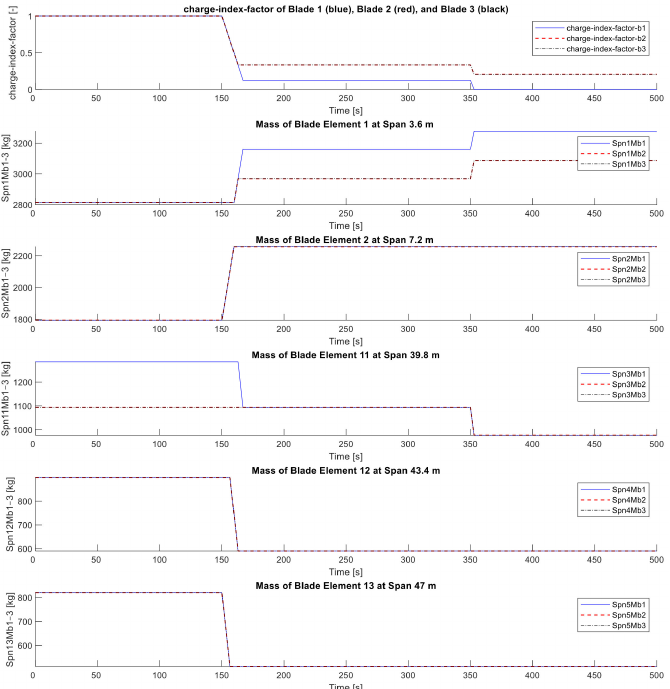
Figure 8. Rotor imbalance due to the additional mass in blade 1, element 11, and elimination of the imbalance by partly charging the flywheel system.